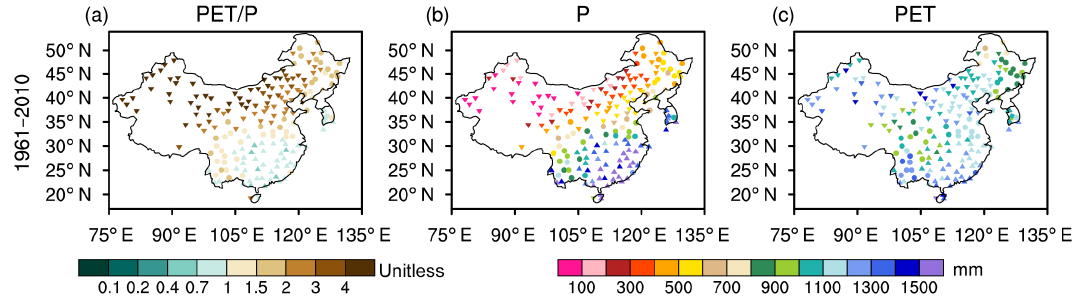
Figure 2. Spatial distributions of the climatologies of PET /P (a) , P (b) , and PET (c) over continental eastern Asia for the period of 1961–2010. Inverse triangles, circles, and triangles represent stations classified as arid, transitional, and humid regions,